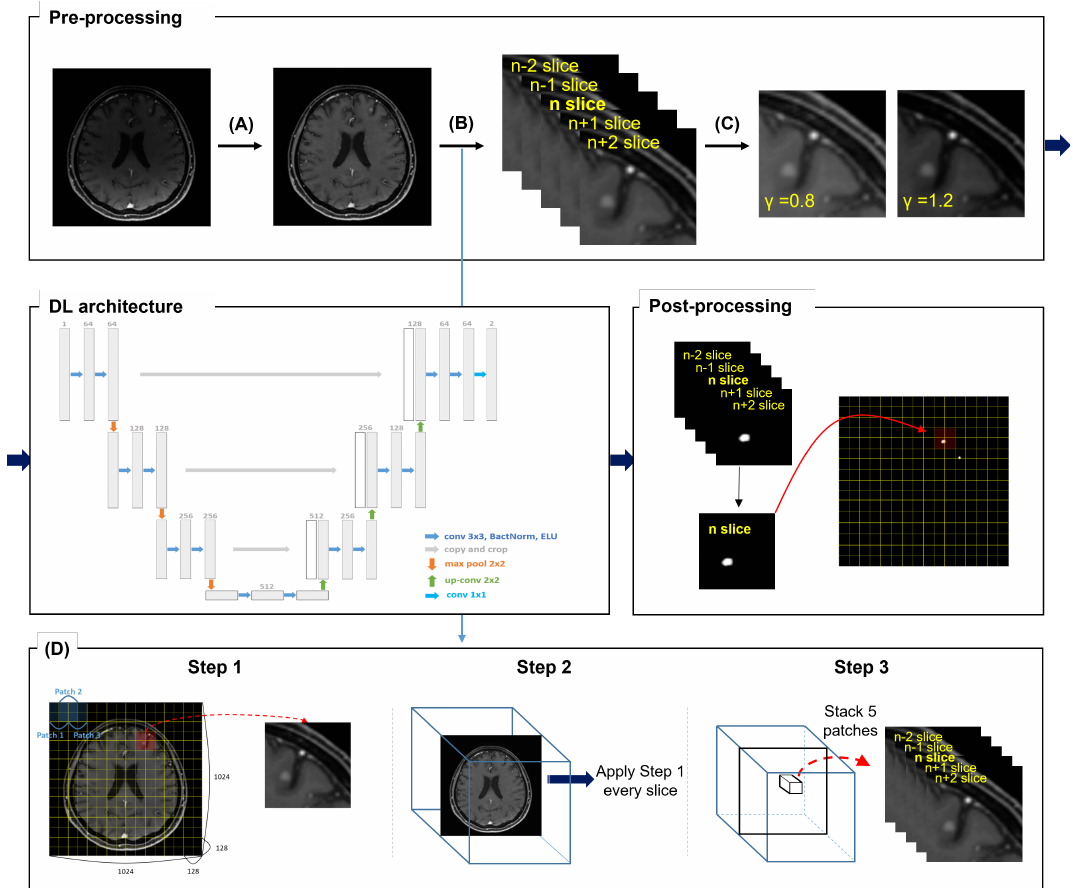
Figure 2. 2D U-Net with preprocessing and postprocessing, which is effective for small volumes. Preprocessing composed of bias field correction ( A ), 2.5D overlapping patch technique ( B ), and random gamma correction ( C ) is applied to the MR image. Postprocessing is applied to prediction through 2D U-Net to obtain results. By cropping the 1024 × 1024 size image by overlapping the 128 × 128 size patch, it was effective for small volumes, and by adding 2 slices in each above and below the reference slice, 5 channels are configured to reflect volume information ( D ). In step 1, form a cropped patch by sliding a 64 × 64 size patch from left to right and top to bottom of the slice. In step 2, apply the process of step 1 to all slices of the patient individually. Finally, in step 3, stack the patches with the same x-y coordinates in 5 slices along the